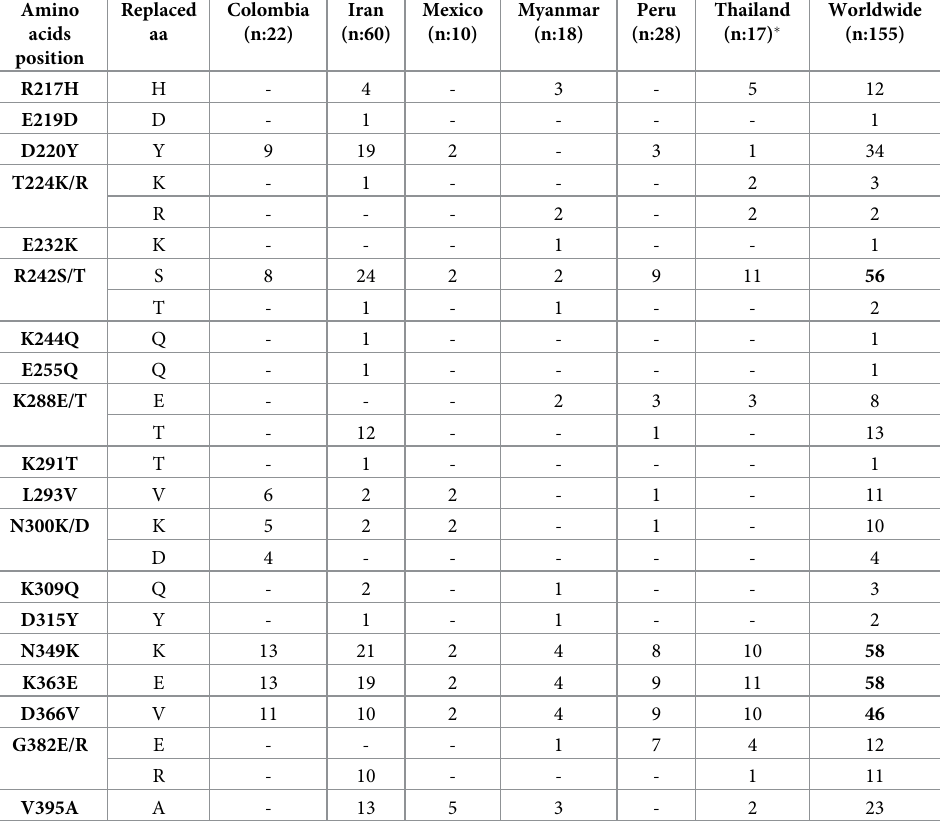
Table 6. The number of amino acid polymorphisms in different positions of PVRBP2b antigen, N-terminal (aa: 168–460) and C-terminal (aa: 461–633) among global isolates. Amino acids